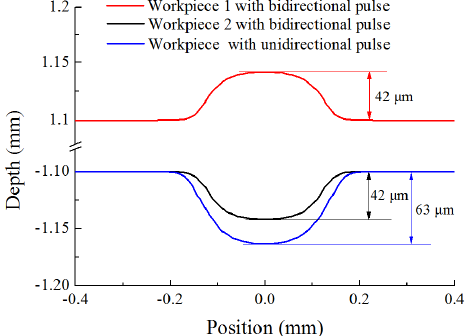
Figure 6. The simulation of cross-section profiles of micro dimples with different machining modes.